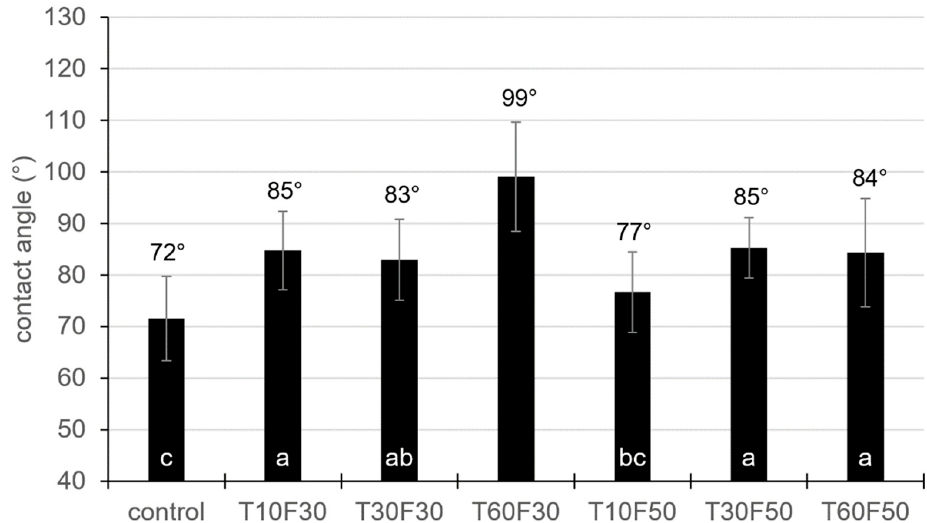
Figure 6. Effect of APD treatment on water contact angle on the surface of the sunflower seeds (the same letter signs the variants that are not significantly different; vertical lines denote standard deviation bars).